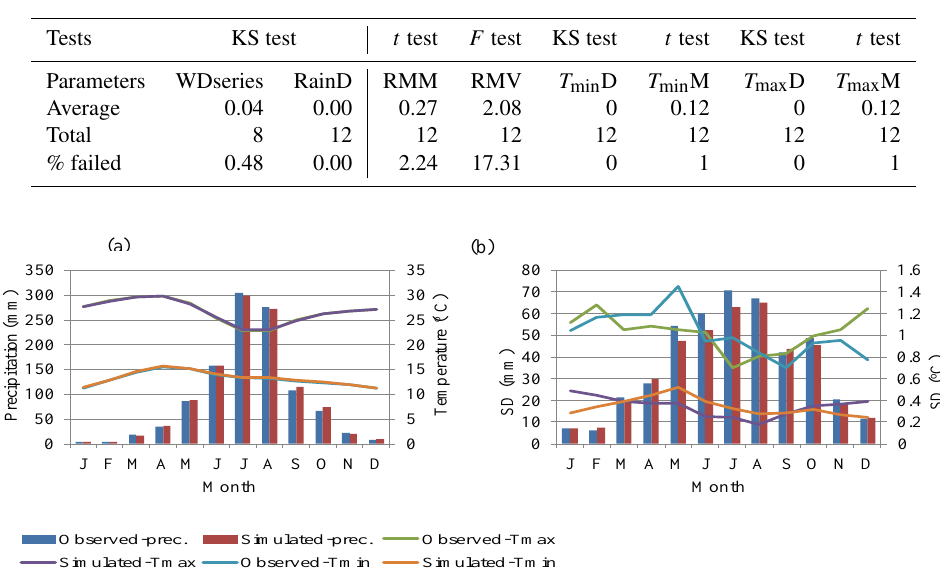
Table 3. Calibration results of the average statistical tests comparing the observed data from 26 stations with synthetic data generated through LARS-WG. The numbers in the table show the average numbers of tests gave a p value of less than 5% significance level.